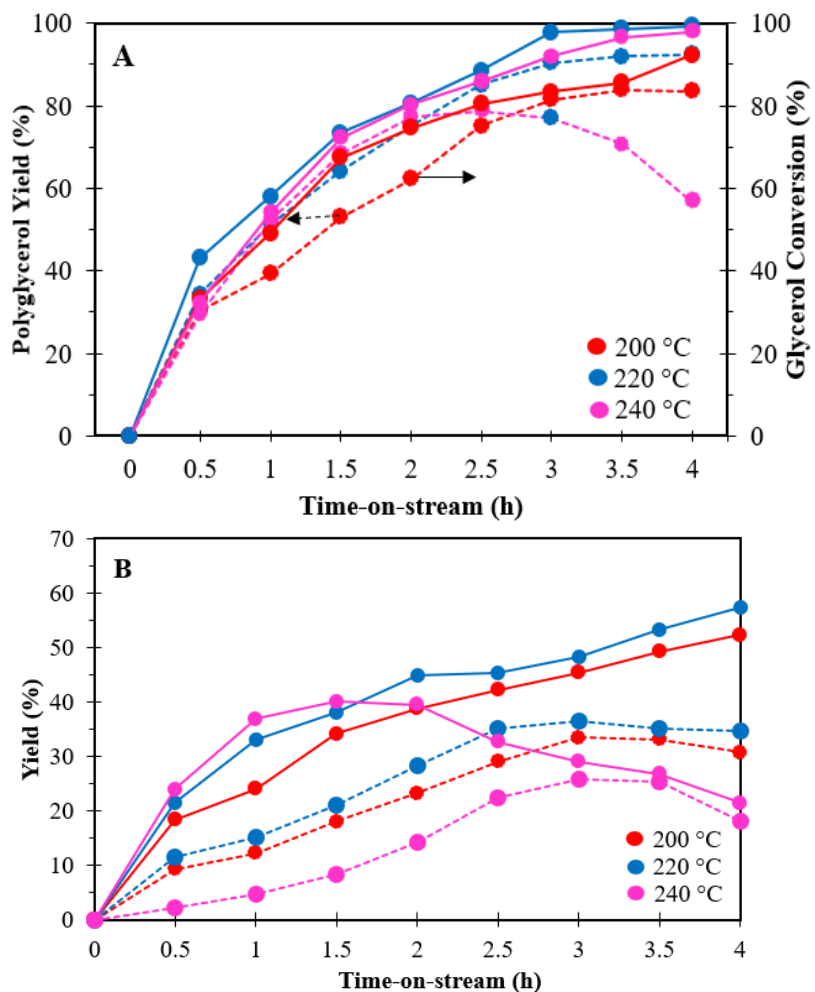
Figure 9. ( A ) Conversion of glycerol to polyglycerol and ( B ) short-chain oligimers (solid line: diglycerol, dotted line: triglycerol) formation in the presence of 2 wt.% of 20 wt.%Li/AlPC.